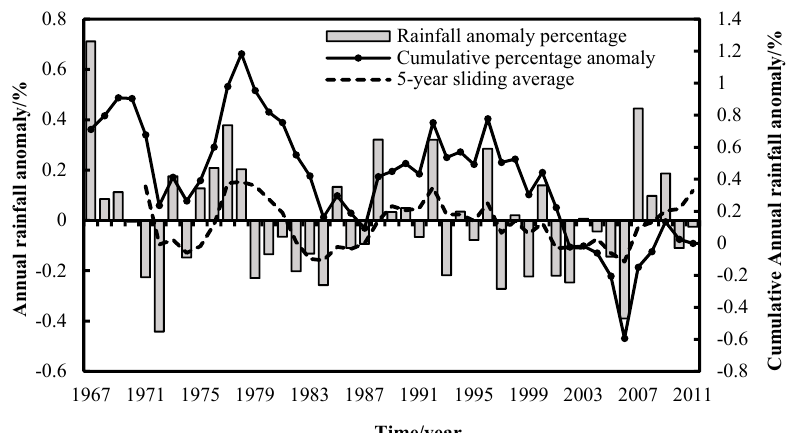
Figure 5. The annual average precipitation departure and accumulated anomalies of the Lanhe Watershed. Figure 5.